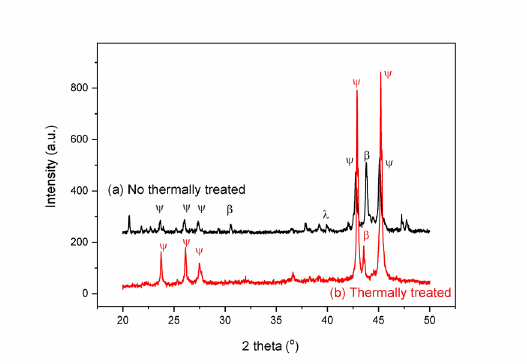
Figure 1. MQP X-ray diffraction patterns (λ=KαCu=0.154184nm): a) no thermally treated; b) thermally